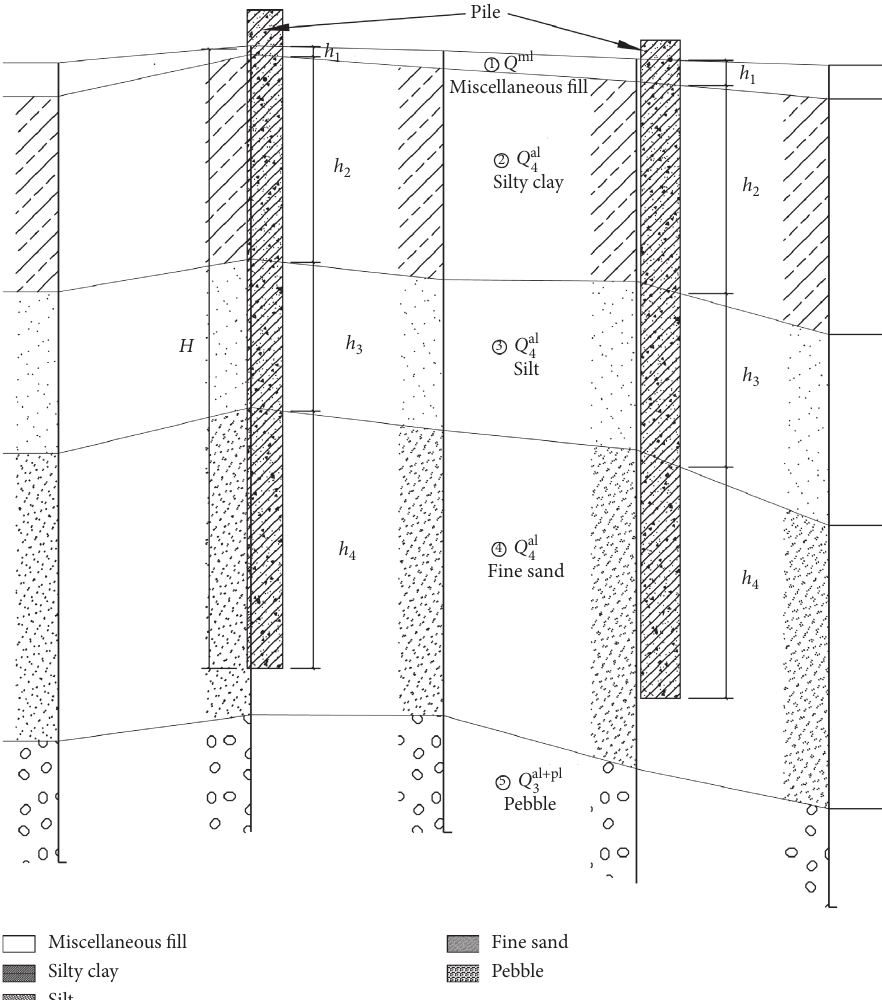
Figure 6: Schematic diagram of h